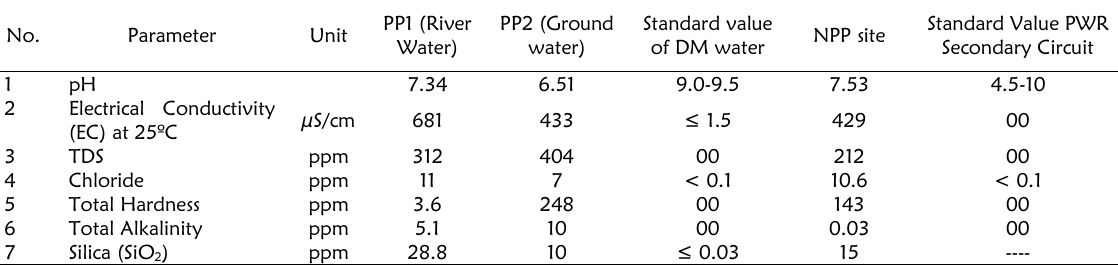
Table 1: Raw water quality parameter of PP1, PP2 & NPP Site with the